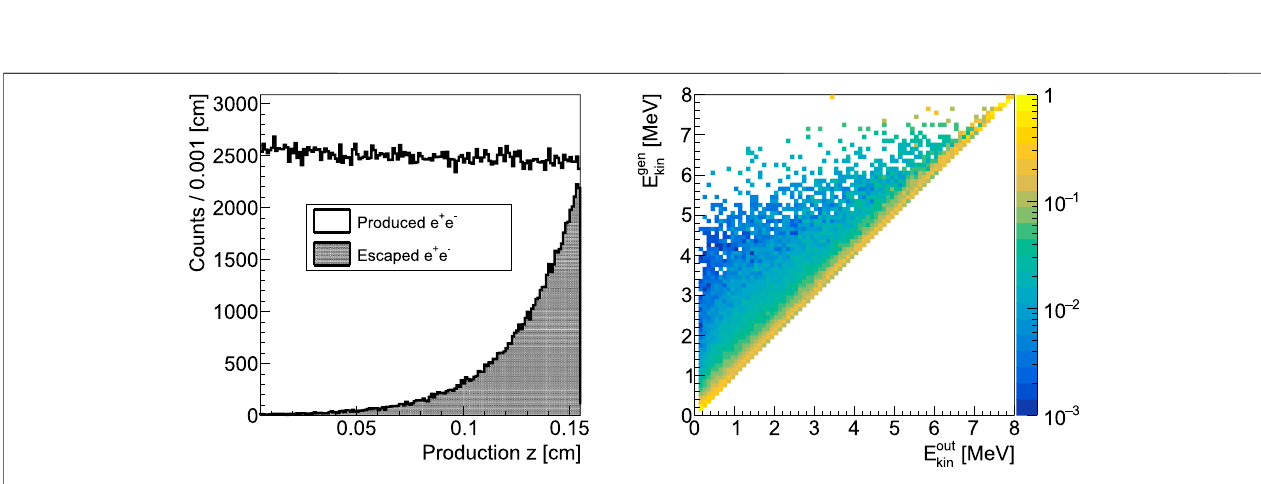
FIGURE3|Left: productioncoordinateofthepairsonthelongitudinalaxiszoftheconverterlayer(whitearea)superimposedtothesamedistributionforthepairsable to exit the converter (black area). The observed exponential behavior represents the pair absorption toward the converter exit face. Right: probability distribution that an electron with a given kinetic energy at the converter exit (E out kin ) is produced with a given kinetic energy at generation (E gen kin ). The same distribution is observed for positrons.